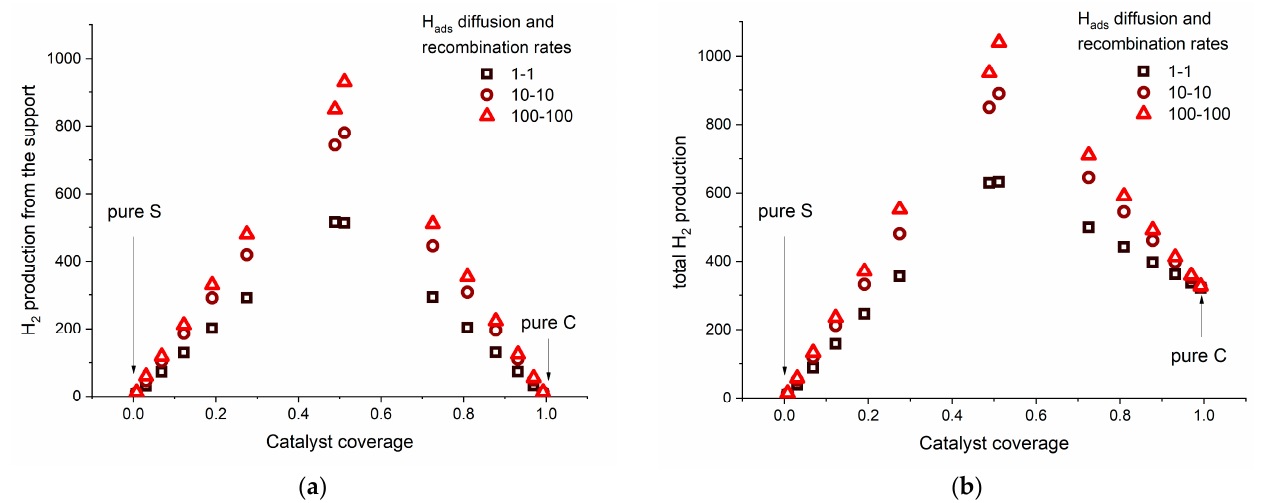
Figure 3. Dependence of the H 2 production rate as a function of the catalyst coverage for three different sets of rates of H ads diffusion and recombination on the support (spillover rate set to 1): ( a ) H 2 production from the support, ( b ) total H 2 production.